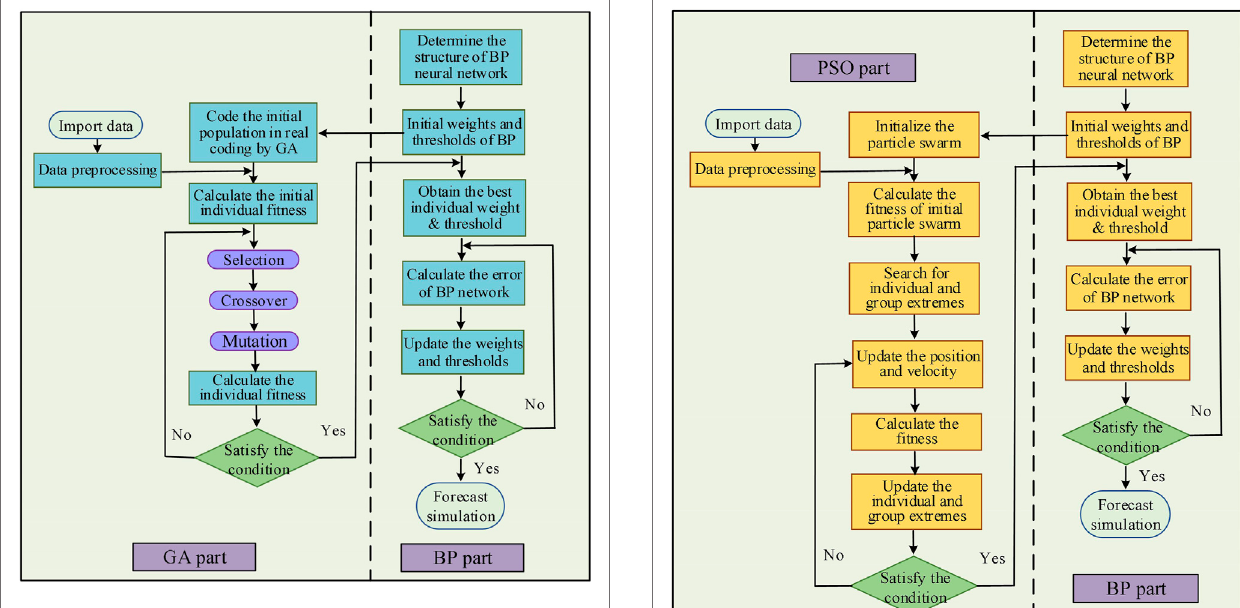
FIGURE 2 | Flowchart of the GA-BP